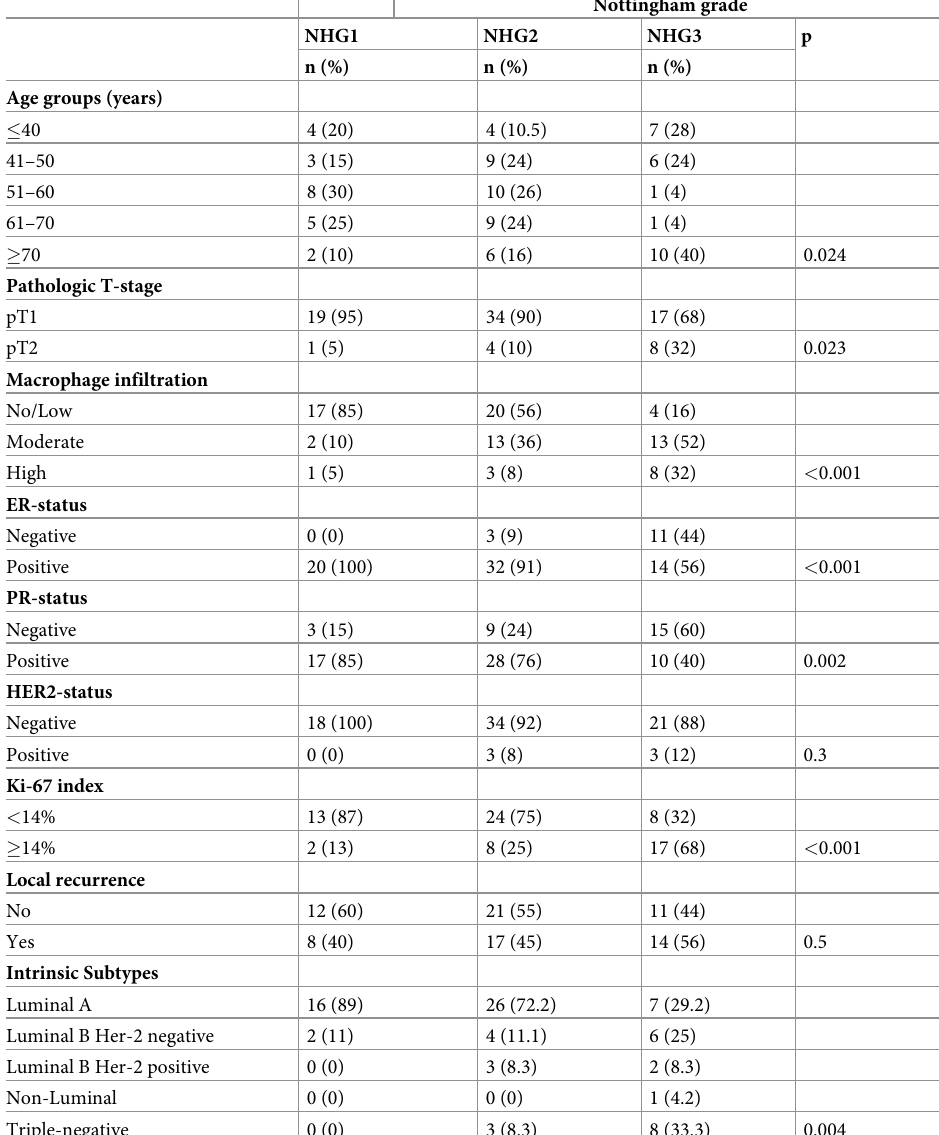
Nottingham grade